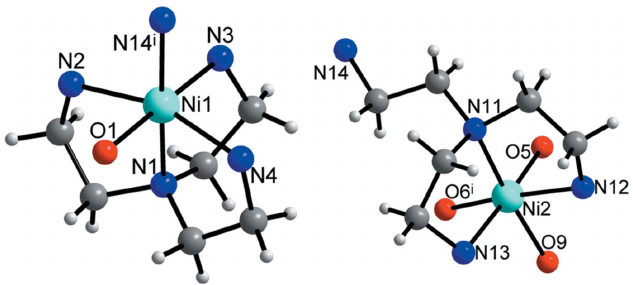
Figure 3 View of the coordination environments of the two Ni II cations with labeling of selected atoms. H atoms bonded to N atoms were omitted for clarity. [Symmetry code: (i) (cid:4) x + 1, (cid:4) y , (cid:4) z + 2.]